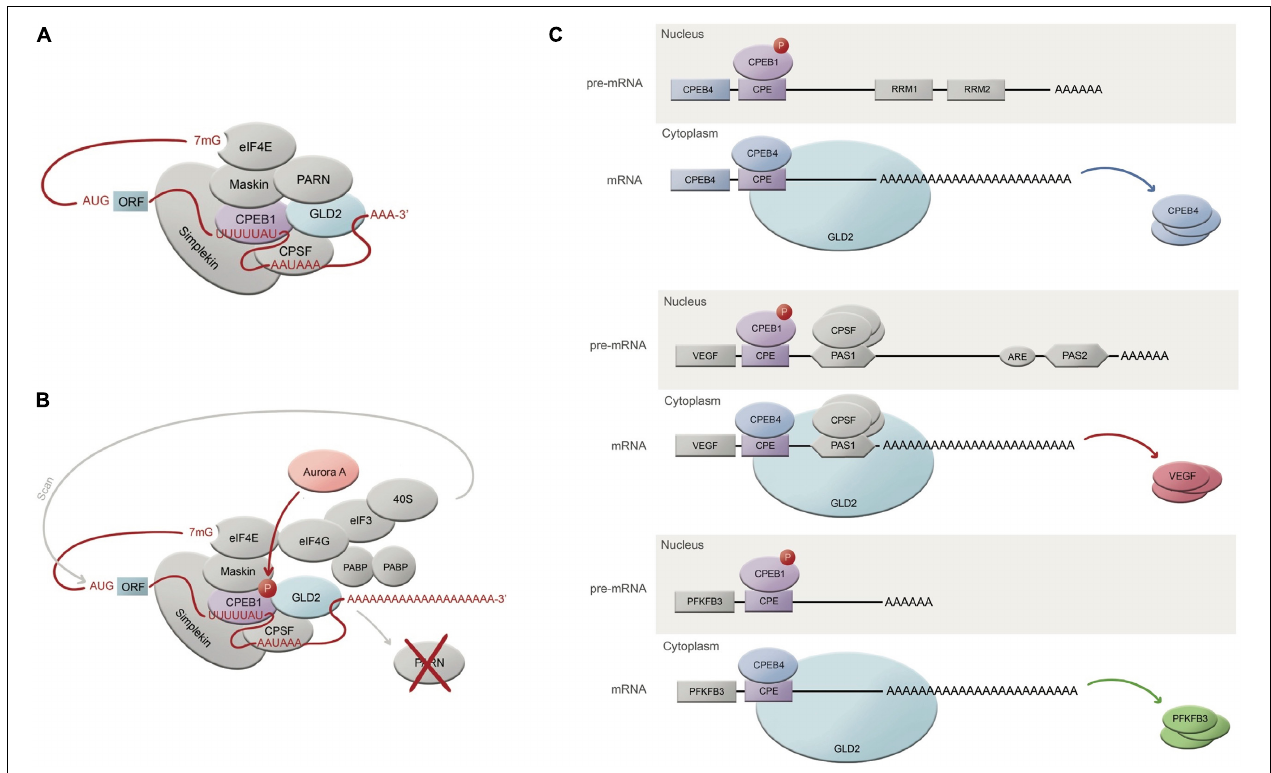
FIGURE 1 | CPEB-regulated mechanism of translational activation through polyadenylation. (A) Translationally repressed mRNA where CPEB1 is bound to the CPE domain (U-rich UUUUUAU sequence), while at the same time, CPSF is associated to a nuclear pre-mRNA site AAUAAA. CPEB1 is at the same time interacting with GLD2 (adenylating enzyme), which is inhibited by its binding to PARN (deadenylating enzyme). PARN shortens the poly(A) tail in this translational repression state. CPEB1 is also bound to Maskin, which interacts with eIF4E, which in turn also cooperates in translational repression by taking the place of eIF4G. Simplekin acts as a platform for the protein complex tethering the repressed mRNA. (B) Upon Aurora A phosphorylation, CPEB1 is thus phosphorylated and activated, which will cause PARN ejection, liberating GLD2 to finally be able to resume polyadenylation. The resulting long poly(A) tail will facilitate the 40S ribosomal subunit to find it, guided by eIF4G-eIF3 complex, finally allowing translation. (C) Roles and mechanism of CPEB1 and CPEB4 in 3 different mRNAs related with the pathophysiology of chronic liver disease; active CPEB1 will bind to the CPE sequence in pre-mRNAs within the nucleus, allowing CPSF to cleave the hexanucleotide domain, originating the mature mRNA. Once the mature mRNA has exited the nucleus, CPEB4 will bind the CPE sequence to enhance polyadenylation and thus prioritizing the translation of poly(A)-rich